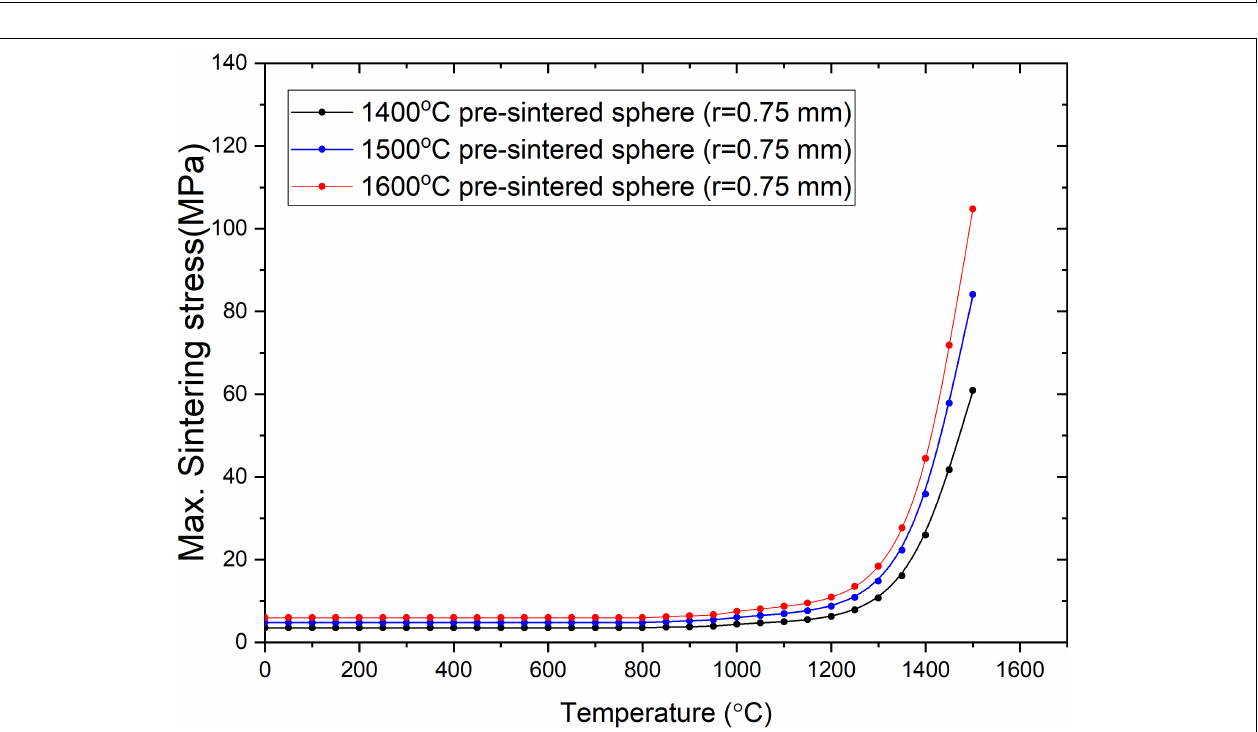
FIGURE 7 | FEA-calculated maximum sintering stress in YSZ oxide pellets containing lumped Gd 2 O 3 spheres of equal size ( r = 0.75 mm) but different shrinkage rates.